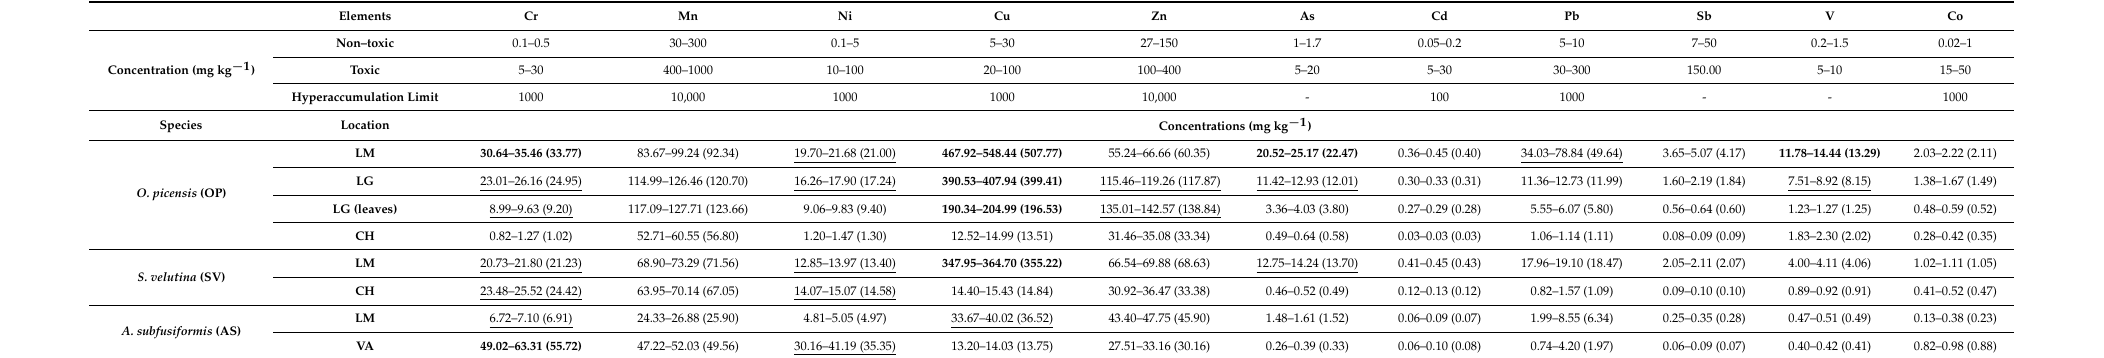
Table 2. Range and mean (in parentheses) element concentrations (mg kg − 1 ) in plants collected at the sampling stations within the Puchuncav í -Ventanas industrial area, i.e., Los Maitenes (LM), La Greda (LG), Cachagua (CH), and Valle Alegre (VA): O. picensis (OP), S. velutina (SV), and A. subfusiformis (AS). Underlined values are within the toxic level for plants, while those in bold are over the toxic